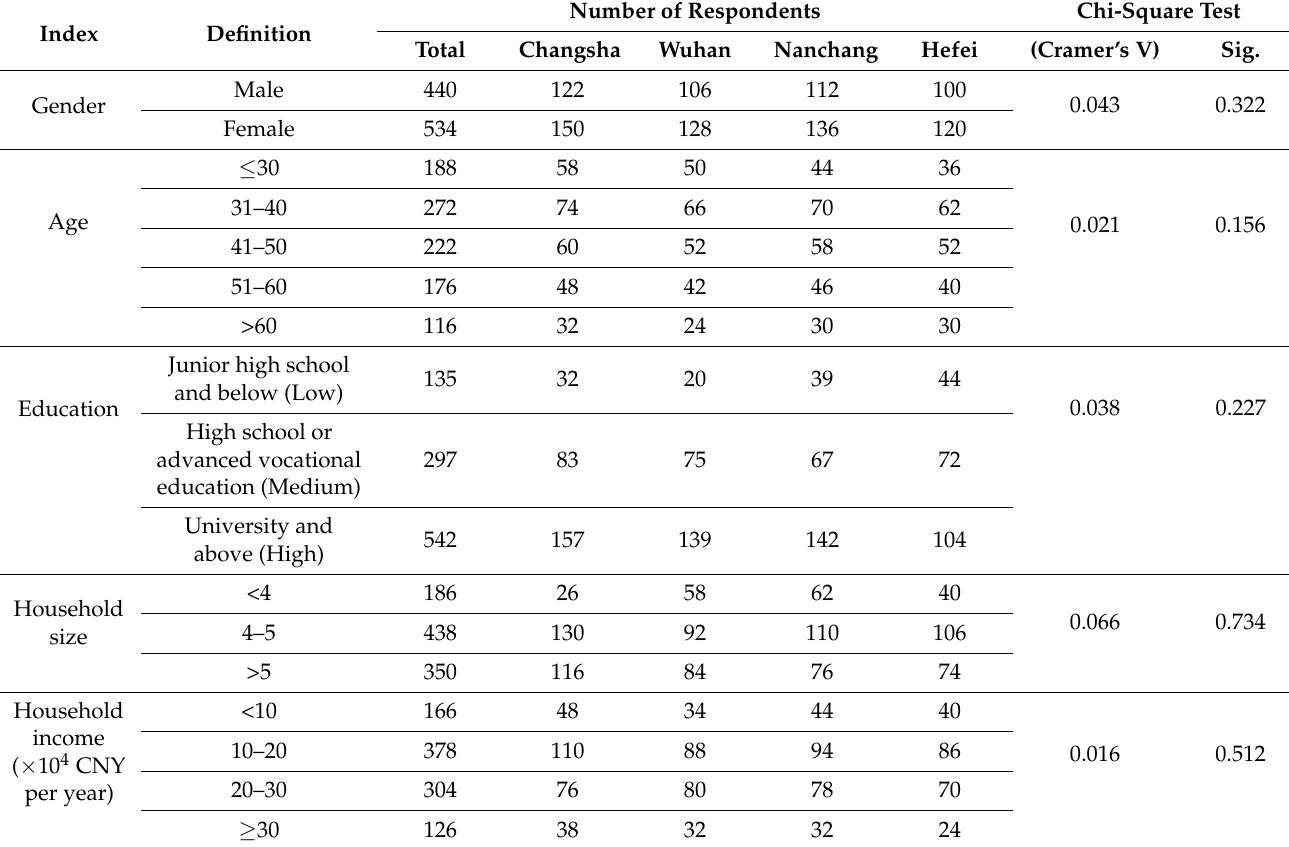
Table 3. The socio-demographic characteristics of the